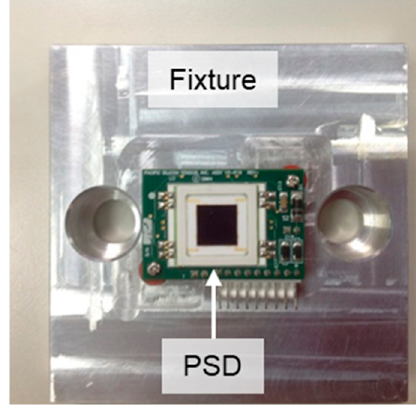
Figure 6. Fixture of PSD (DL100-7-PCBA3).